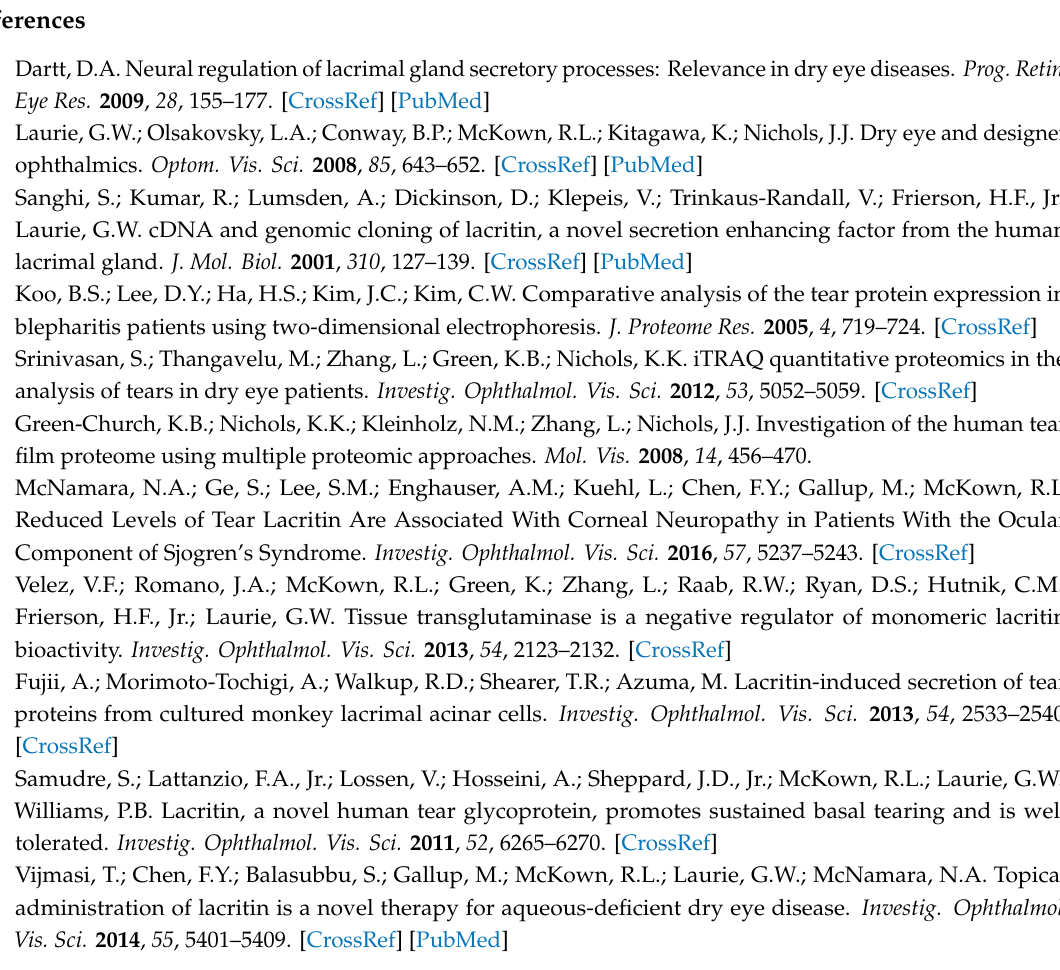
Figure A4. Time-dependent differential release rate of exosomes from HCE-T cells. ( A ) Exosome amounts in culture media were quantified and ( B ) the rate of release was calculated at 36 and 72 h post-treatment. HCE-T cells were treated with 1 μ M LP-A96. The total amount of exosomes and the rates of exosome biogenesis / release were higher during the 0~36 h period compared to 0~72 h period. This suggests the rate of exosome uptake / turnover exceeds the rate of exosome biogenesis / release during 36~72 h period as cells reach confluence. *** p < 0.001, ** p < 0.01. Mean ± SD.